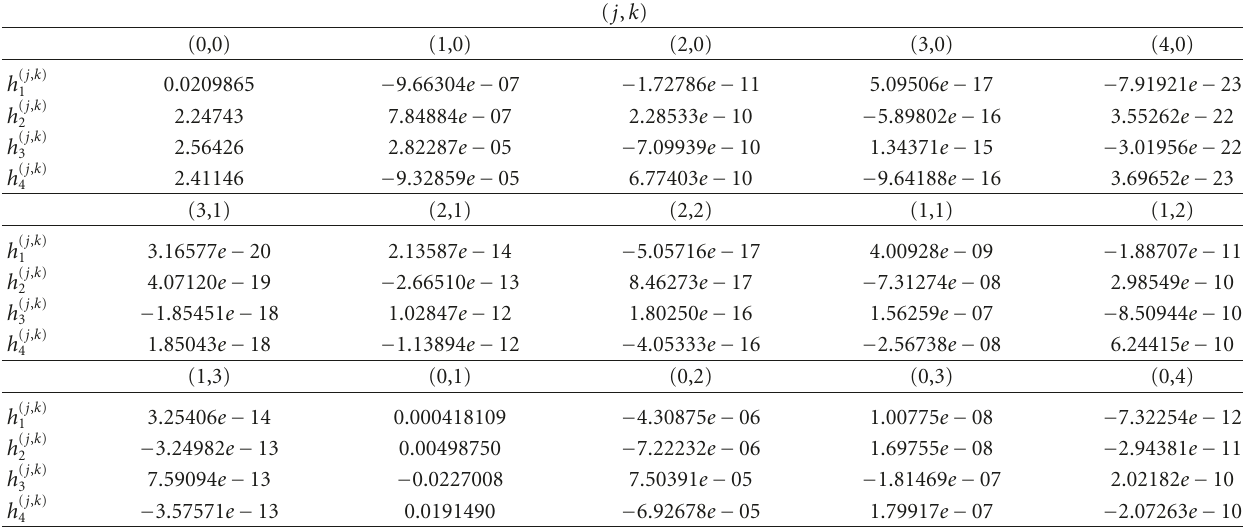
Table 3: Coe ffi cients h ( j , k ) subjected to the polynomials h 1 through h 4 . Although some values seem to be negligible, all values significantly i influence the resulting probability of